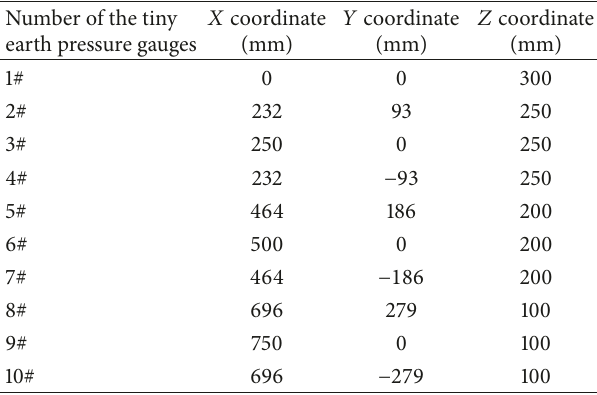
Table 1: Coordinates of the monitoring points.